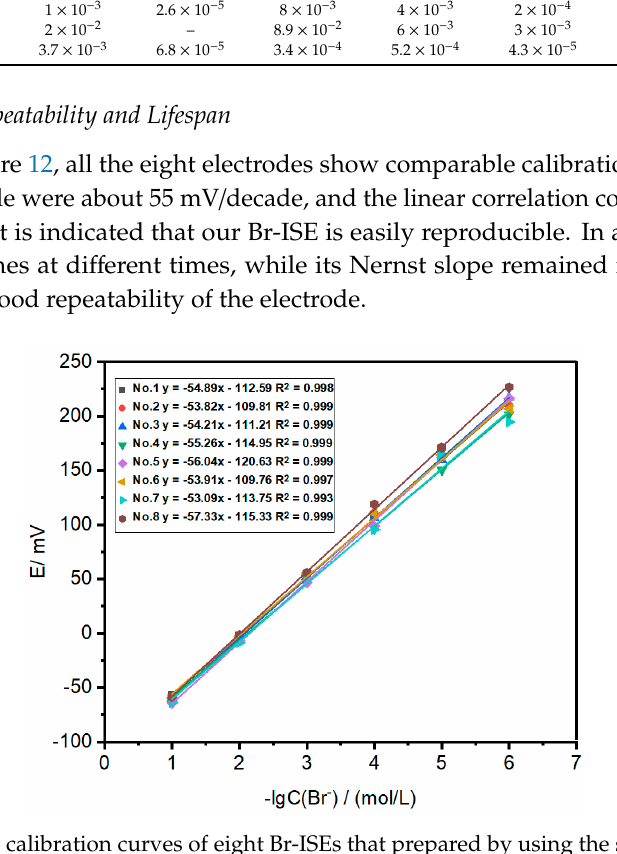
Figure 12. The calibration curves of eight Br-ISEs that prepared by using the same method. Table 2. Calibration result of Br-ISE in 90 days.